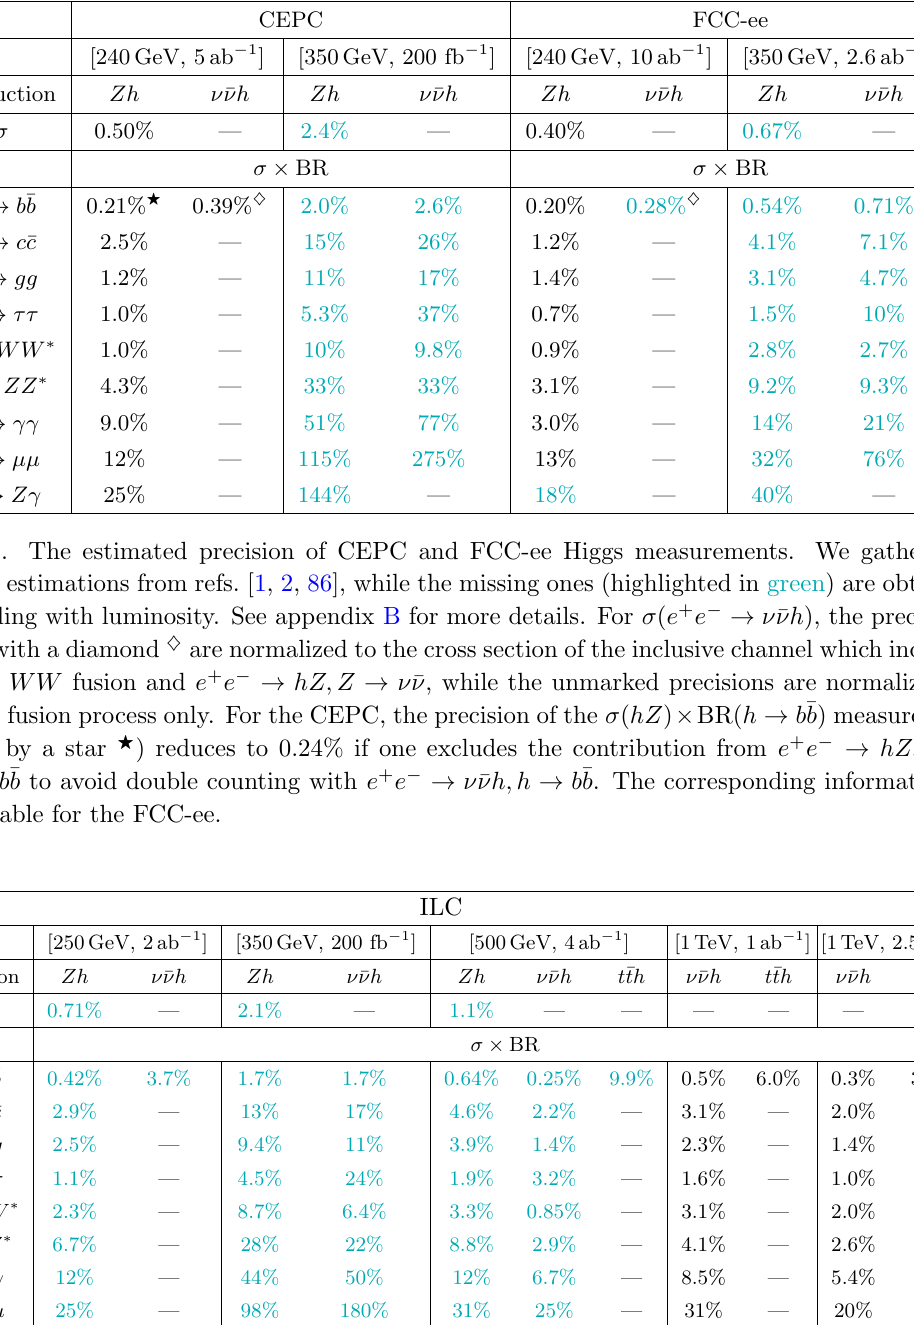
BR( h Z(cid:13) ) (cid:2) ! + ) = ( 0 : 8 ; +0 : 3) is (cid:0) ; e (cid:0) + ) = ( 0 : 8 ; +0 : 2). (cid:0) ; e (cid:0)